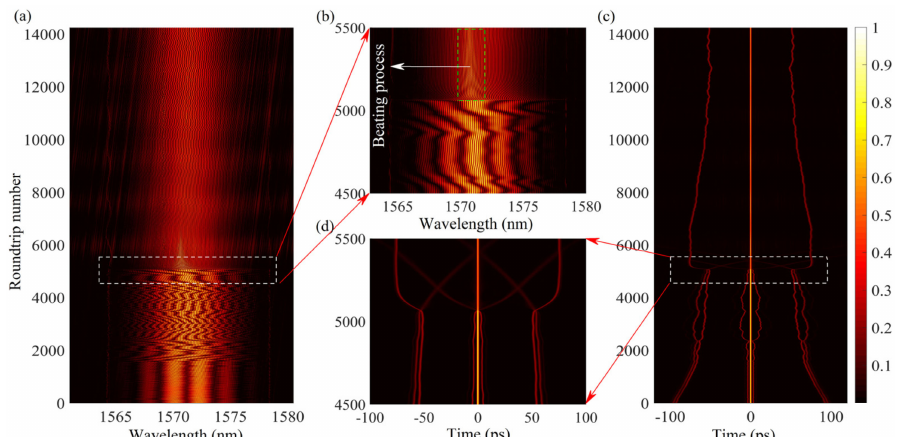
Figure 6. Annihilation of an initial soliton. ( a ) The real-time spectral evolution measured by the DFT technique, ( b ) zoom-in plot of the dashed rectangle in ( a ), ( c ) the field autocorrelation traces, and ( d ) zoom-in plot of the dashed rectangle in ( b ).